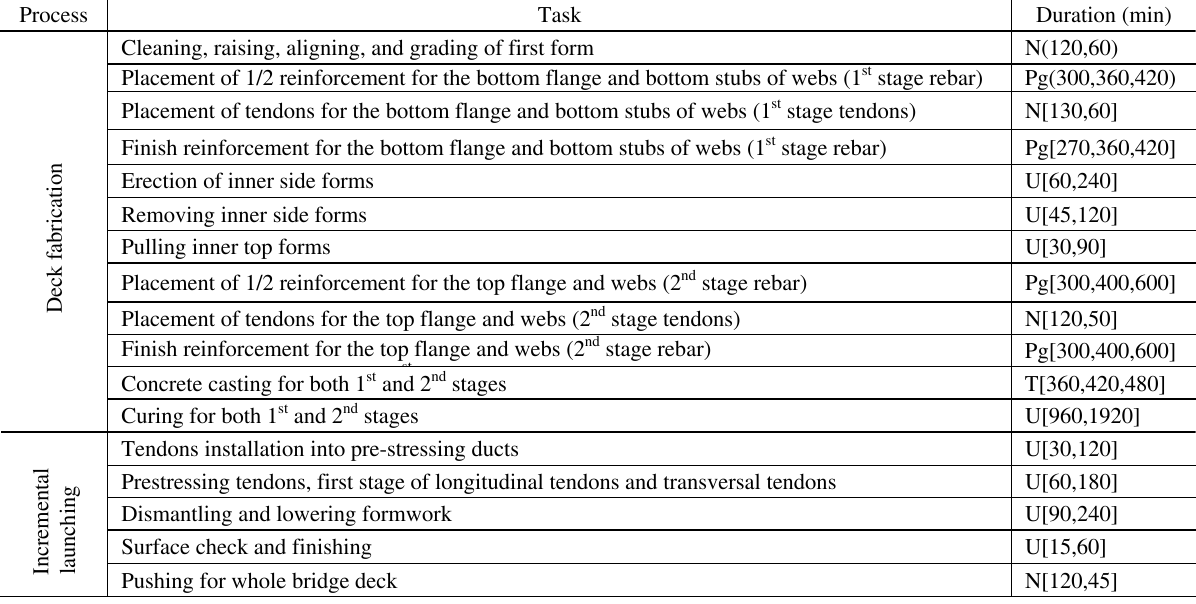
Table 6 . Durations of multiple forms method tasks Process Task Duration (min) Cleaning, raising, aligning, and grading of first form